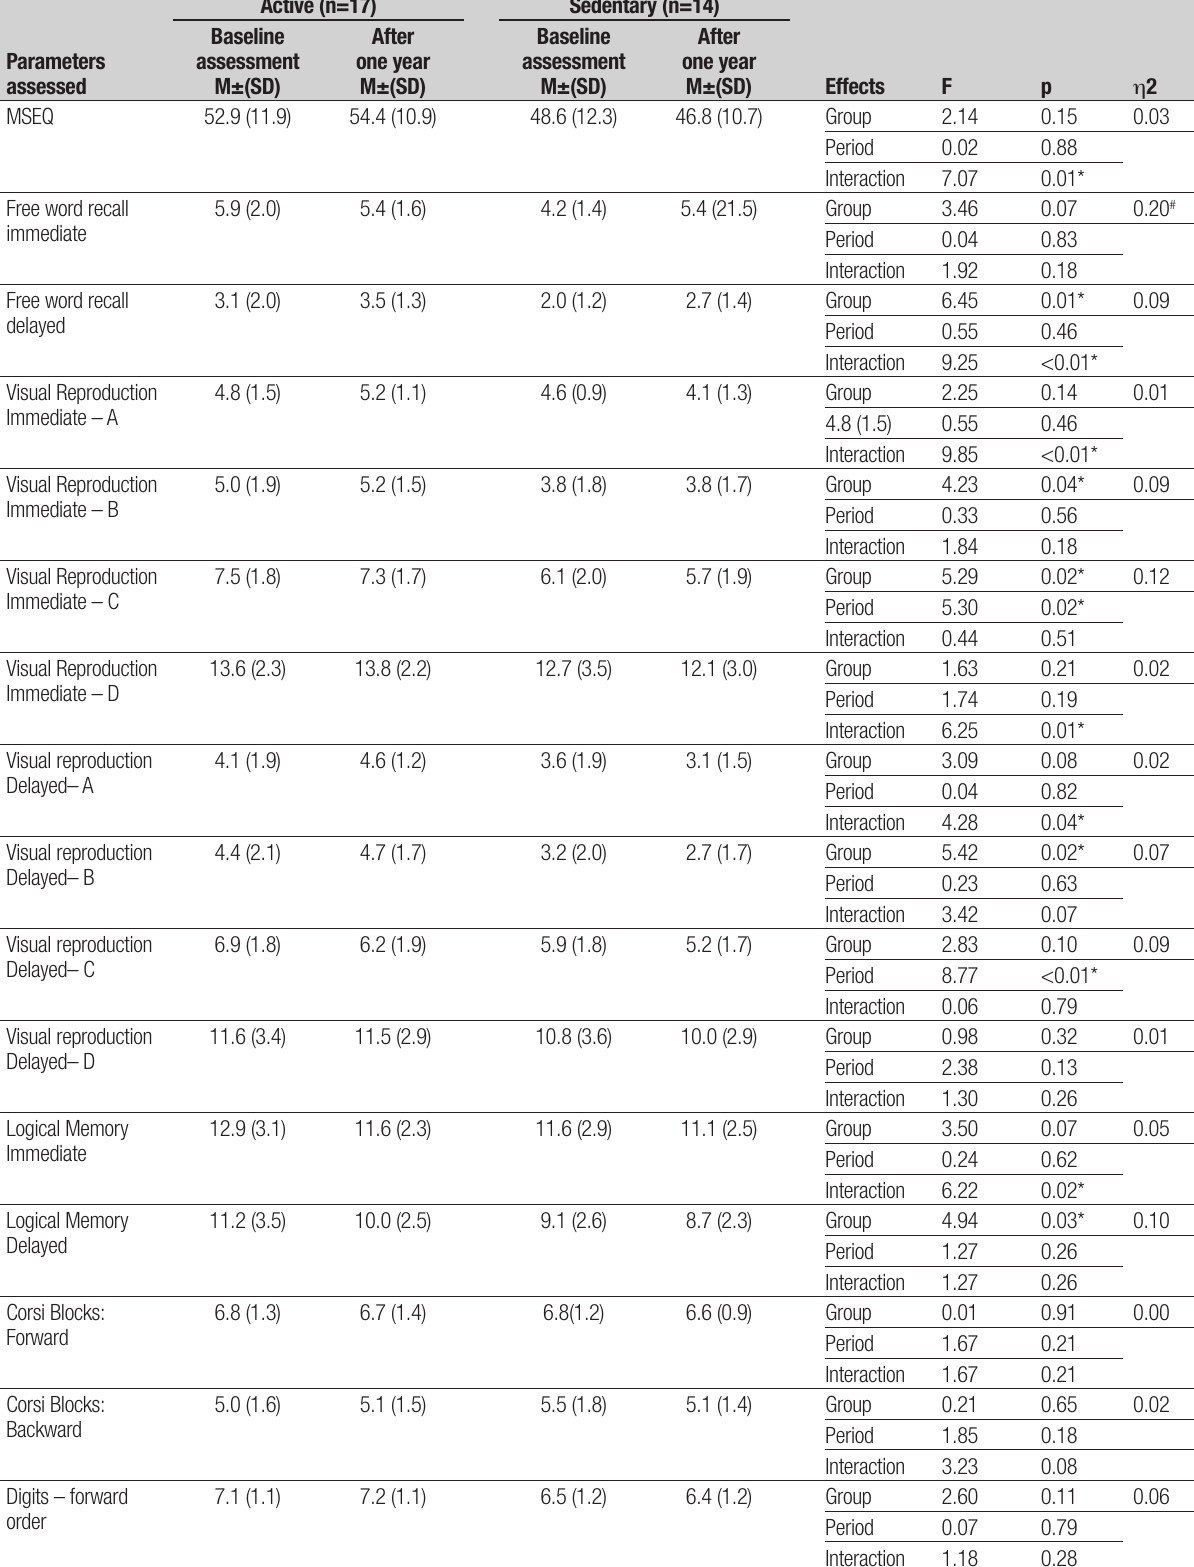
Table 2. Comparisons between performances by Groups on parameters assessed by neuropsychological assessment at baseline and after one year.